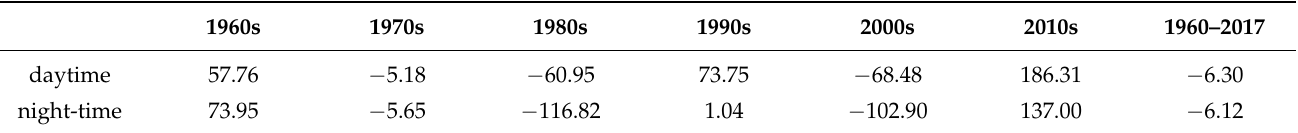
Table 2. Interdecadal linear trends (mm/10 yr) of precipitation on annual